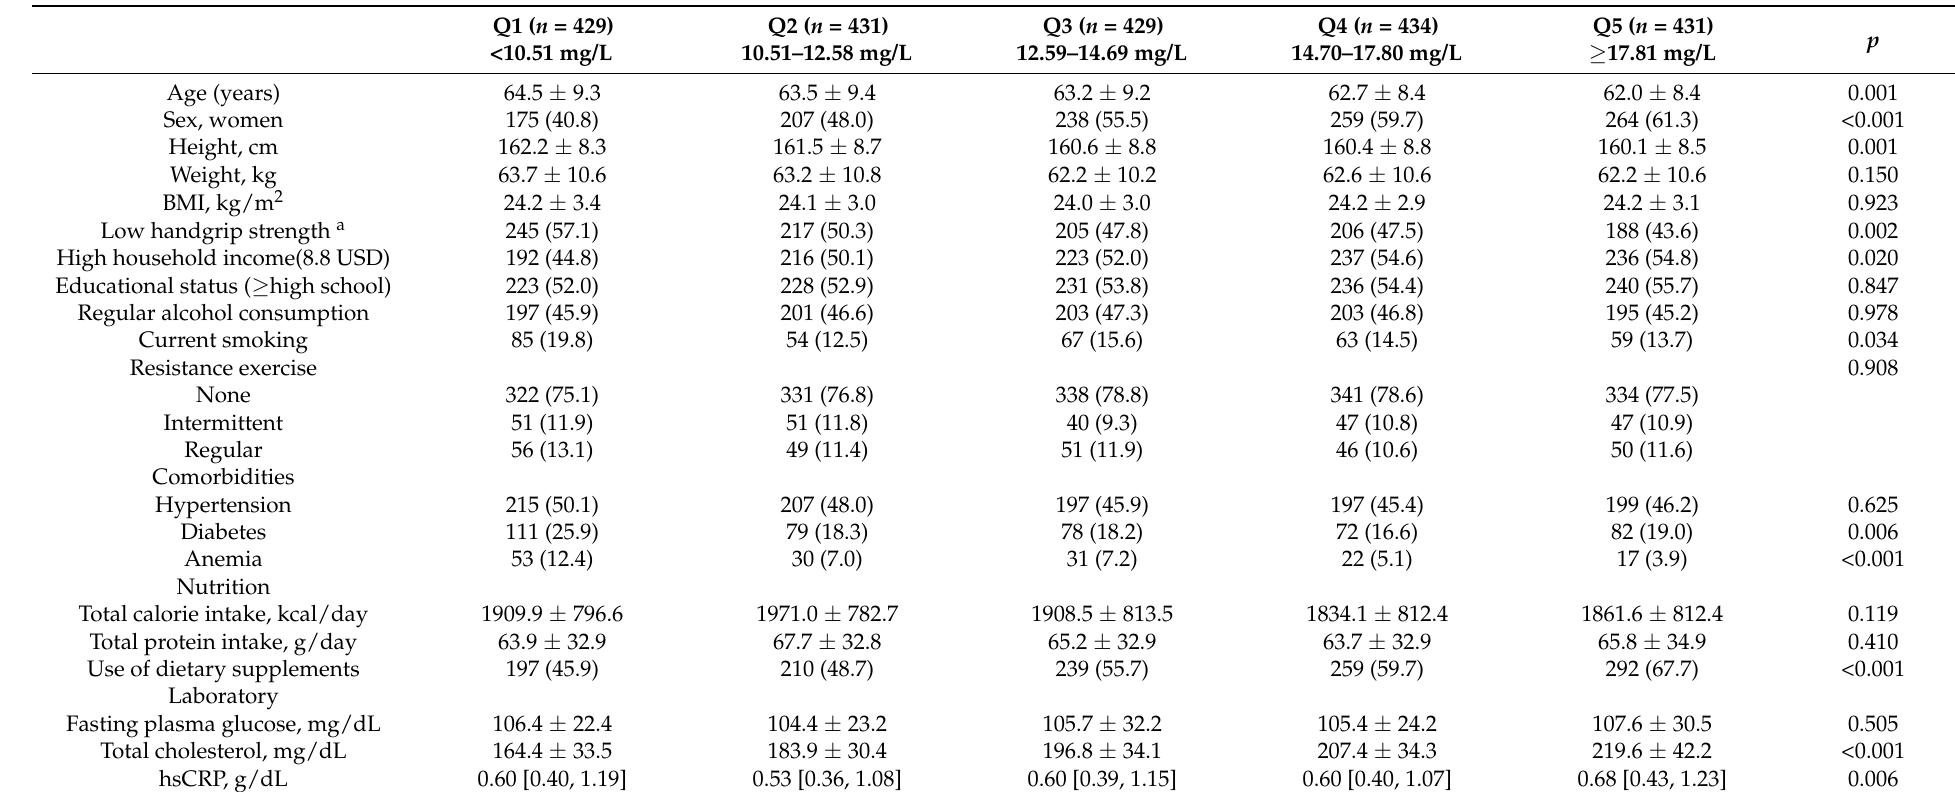
Table 1. Baseline characteristics of the study population according to serum vitamin E levels grouped by